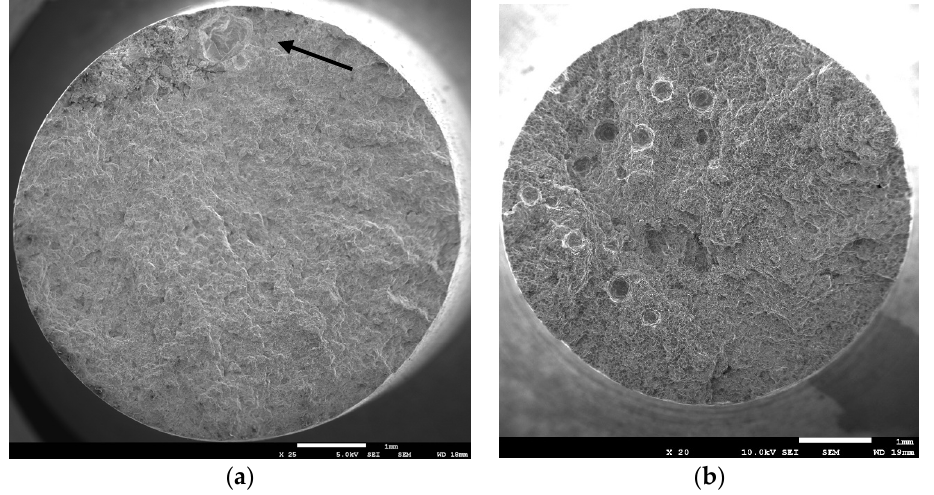
Figure 4. The fracture surfaces of a tensile test sample from ( a ) alloy B SDAS 10 having an oxide defect indicated by the arrow and ( b ) alloy D SDAS 25 having visible round pores with a total area fraction of 2.5%.